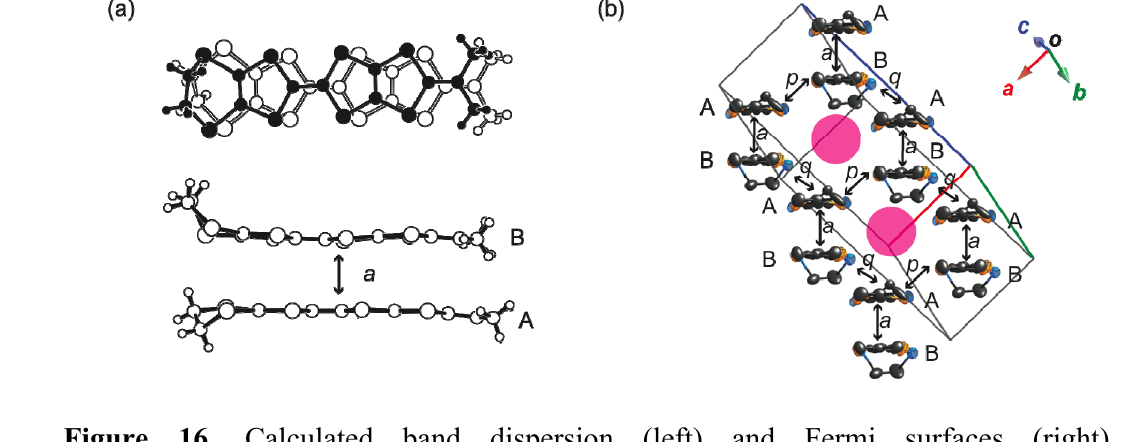
Figure 16. Calculated band dispersion (left) and Fermi surfaces (right) of (MeDTES) 3/5+ ( I